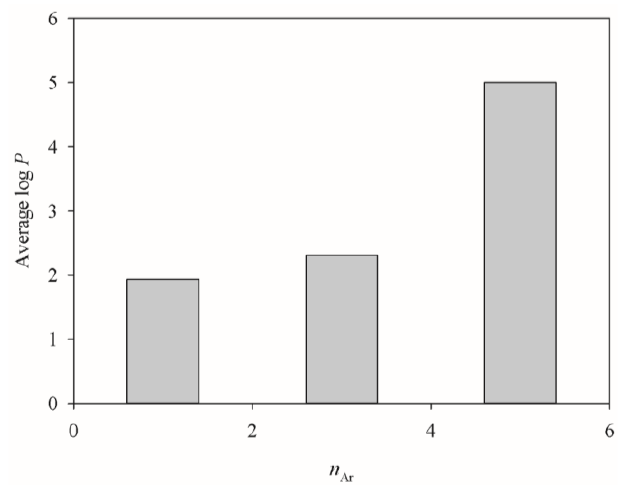
Figure 8. Average log P vs. the distribution of number of aromatic ring ( n Ar ).